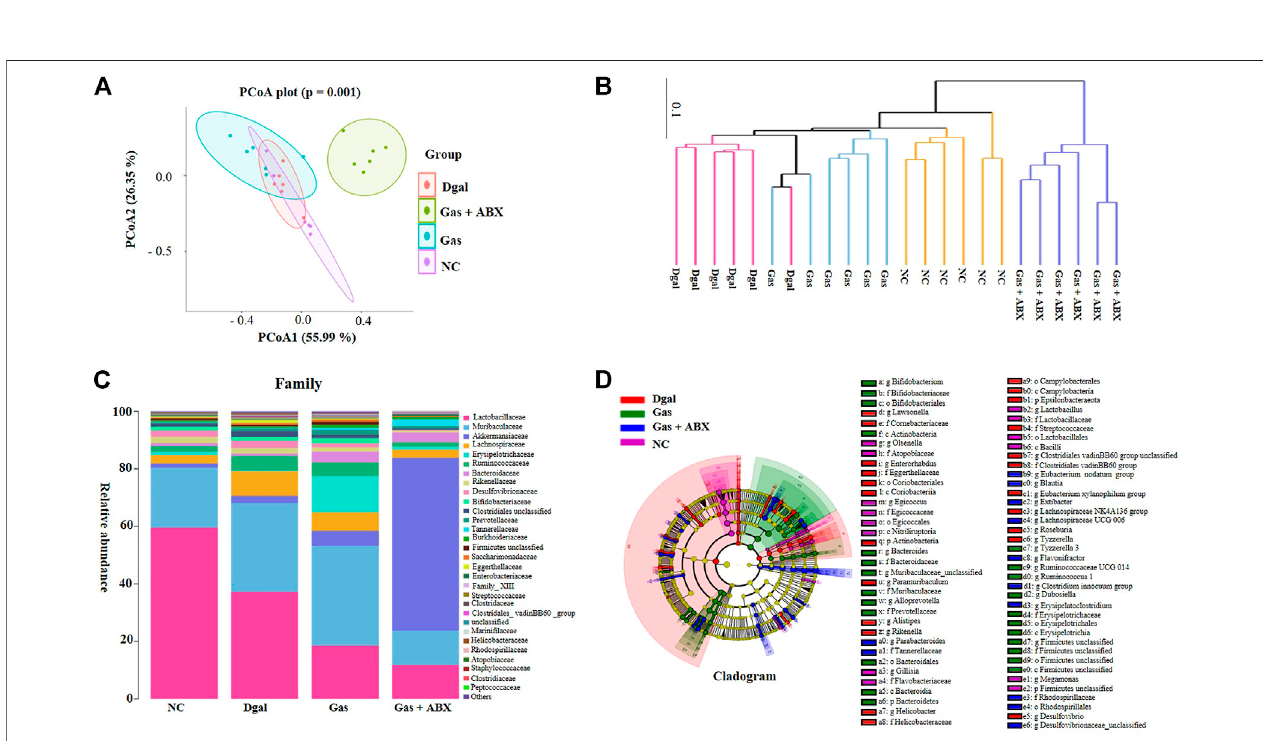
FIGURE 7 | Effects of Gas and antibiotics cocktail on the gut microbiota composition of AD mice. (A) PCoA of gut microbiota in all groups. (B) UPGMA tree of gut microbiota in all experimental groups. (C) Stacked bar chart of the relative abundance of gut microbiota at the family level. (D) Cladogram ofgut microbiota in all groups.